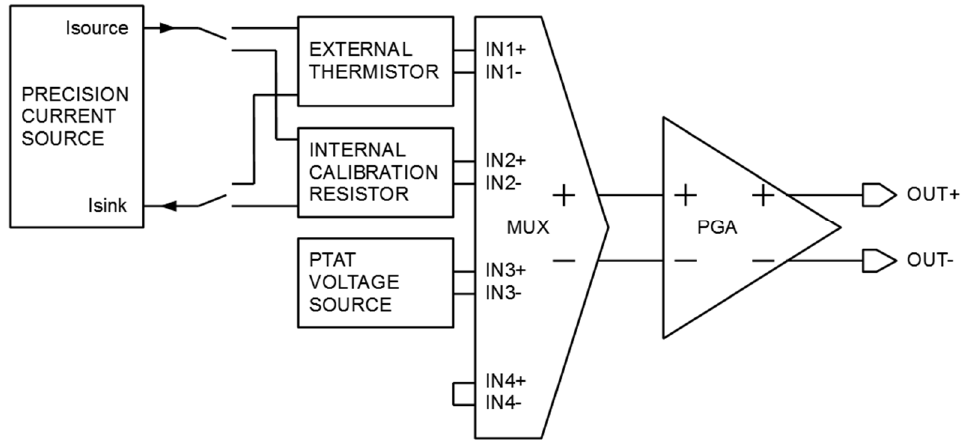
Figure 2. A simplified block diagram of the analog frontend.